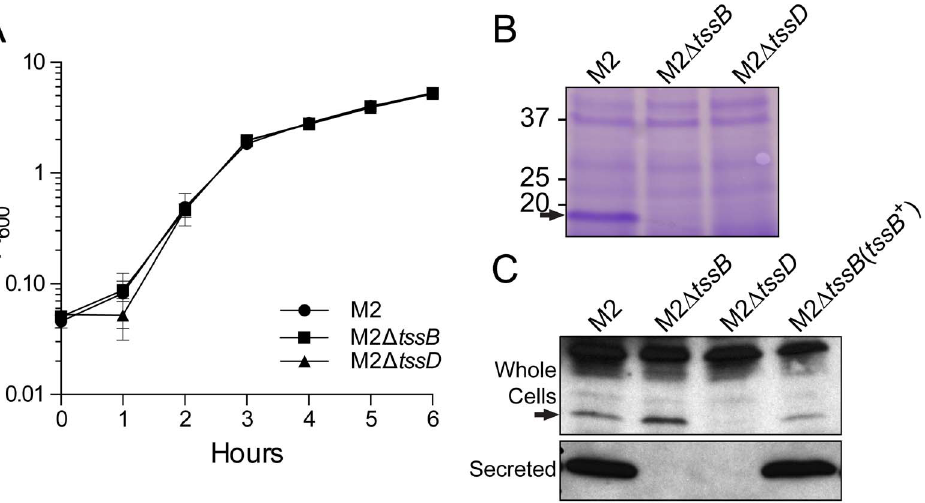
Figure 2. Acinetobacterbaumannii strain M2 secreted Hcp. A. Growth curves of strain M2 and the isogenic tssB and hcp mutants. Three biological replicates were performed; error bars denote the standard error of the mean of the biological replicates. B. Concentrated culture supernatants from strain M2, M2 D tssB and M2 D hcp analyzed by SDS-PAGE and Coomassie staining. A band corresponding to the approximate molecular mass of Hcp ( , 19 kDa), indicated by the arrow, was observed in the sample derived from strain M2 and was absent in the samples from M2 D tssB and M2 D hcp . Mass spectrometry confirmed that the major protein in this band was Hcp. C. Western blot analysis of whole cell lysates and concentrated culture supernatants of A. baumannii strains. Hcp, indicated by the arrow, was detected in whole cell lysates of strain M2, M2 D tssB and the complemented tssB mutant as well as in concentrated culture supernatants of strain M2 and the complemented tssB mutant.